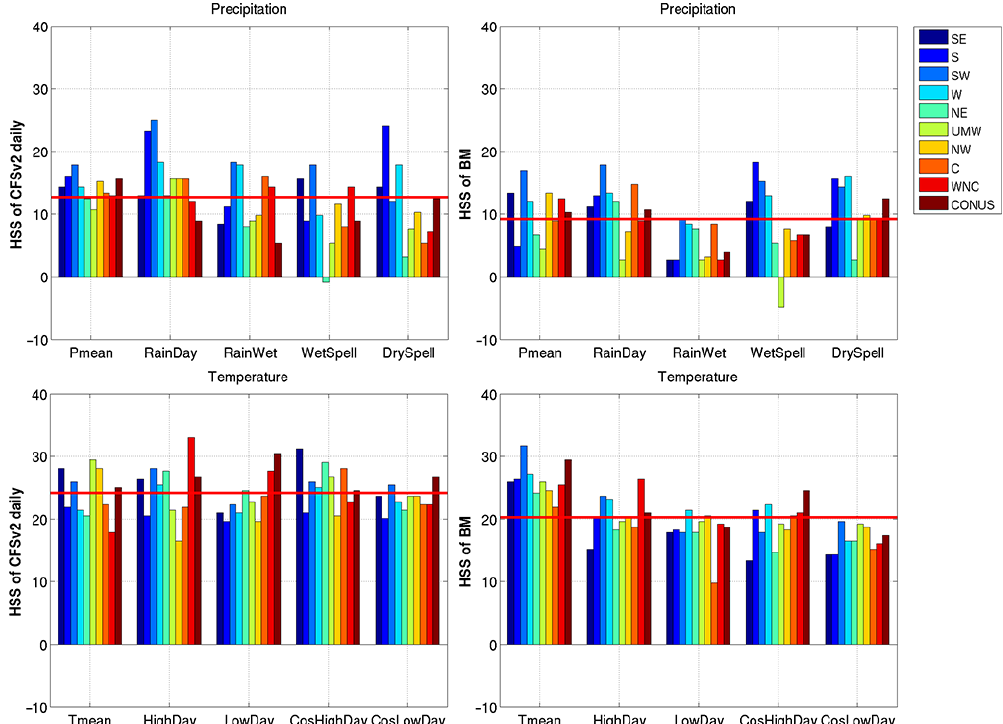
Figure 8. HSS of 30-day precipitation and temperature indices calculated from the CFSv2 and BM for the CONUS and its consistent NCEI climate regions. The red line is the average.